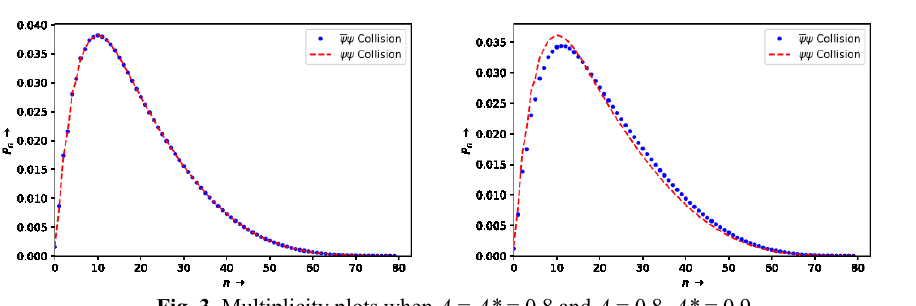
Fig. 3. Multiplicity plots when A = A* = 0.8 and A = 0.8, A* = 0.9.